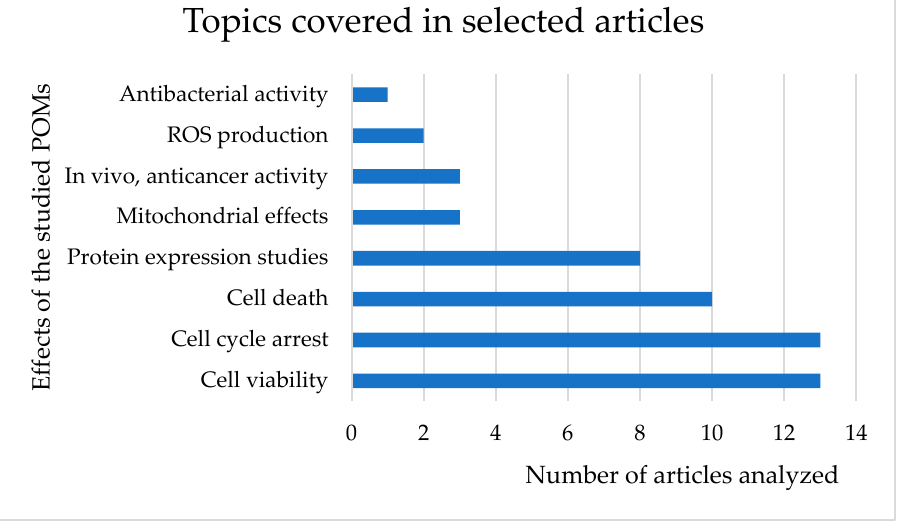
Figure 3. Number of articles in which each effect of the selected POMs was analyzed.